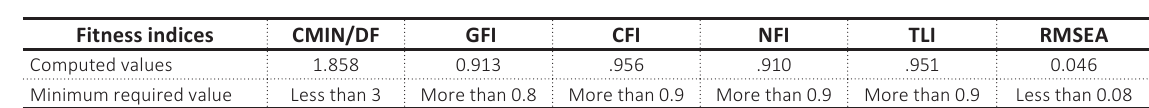
Table 7. Statistical fitness